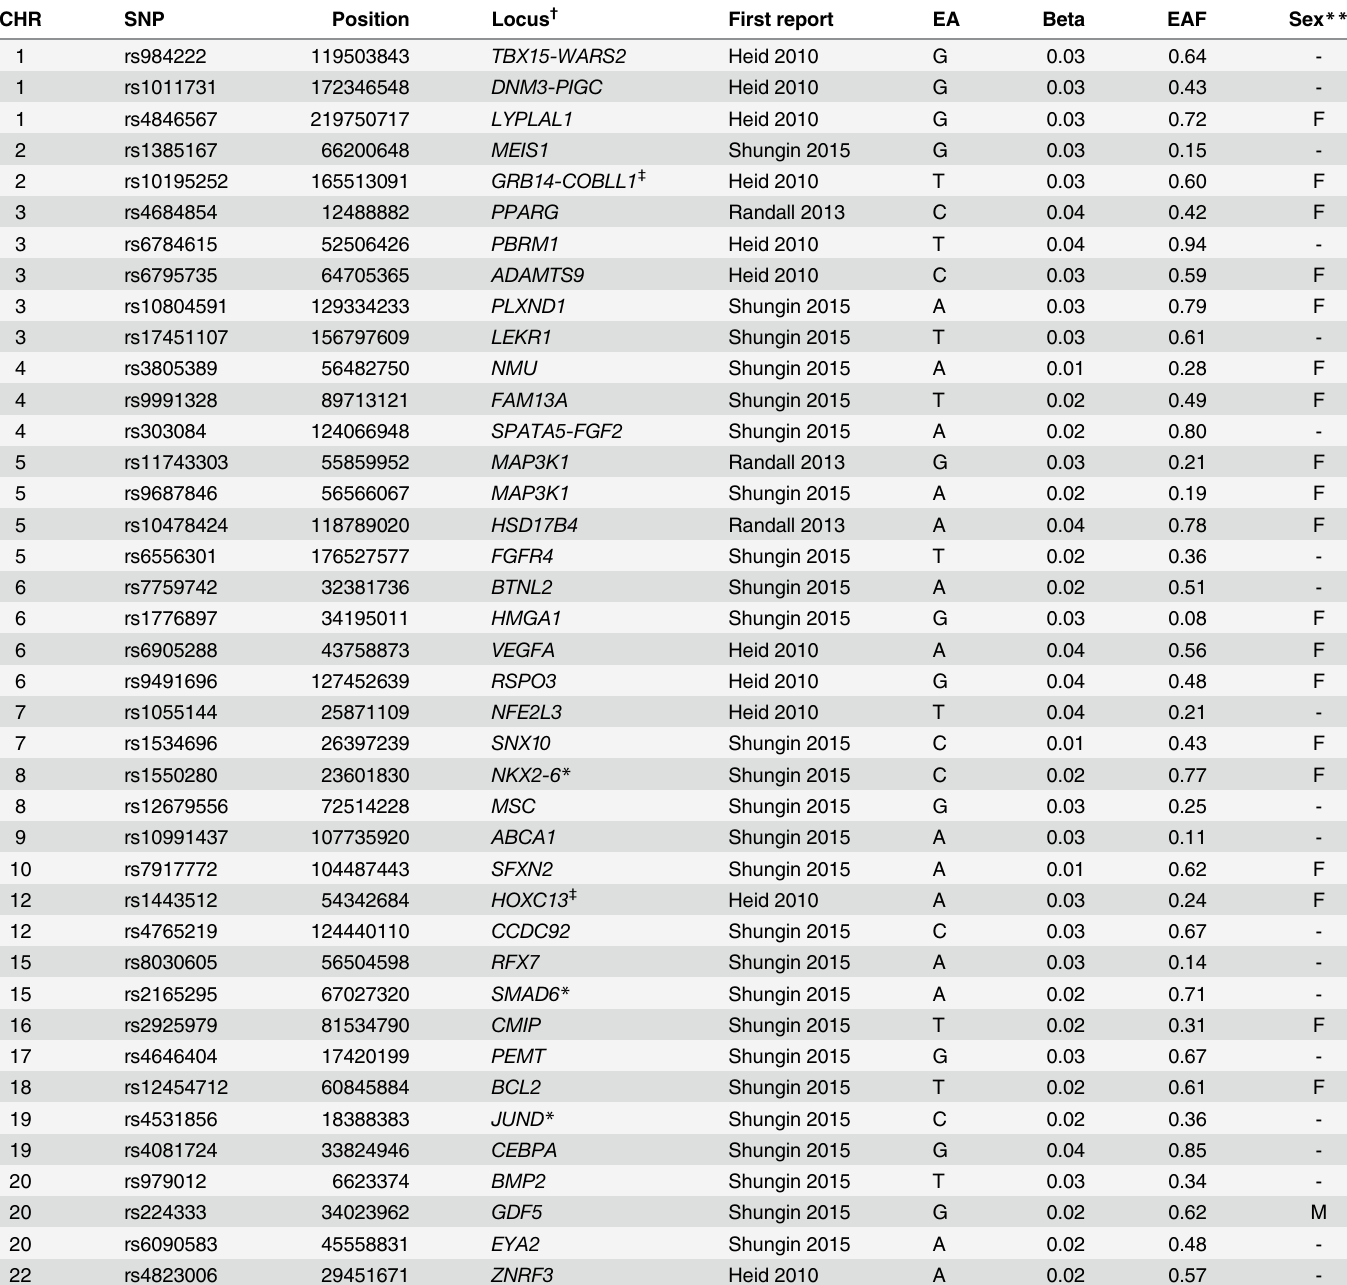
Table 2. Characteristics of genotyped SNPs tagging 40 of 49 known WHRadjBMI-associated